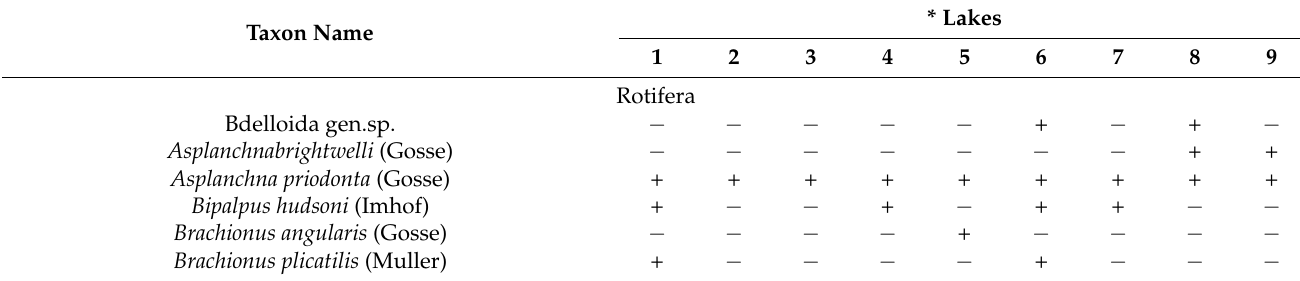
Table 6. Taxonomic composition of zooplankton in small lakes in South-East Kazakhstan, summer